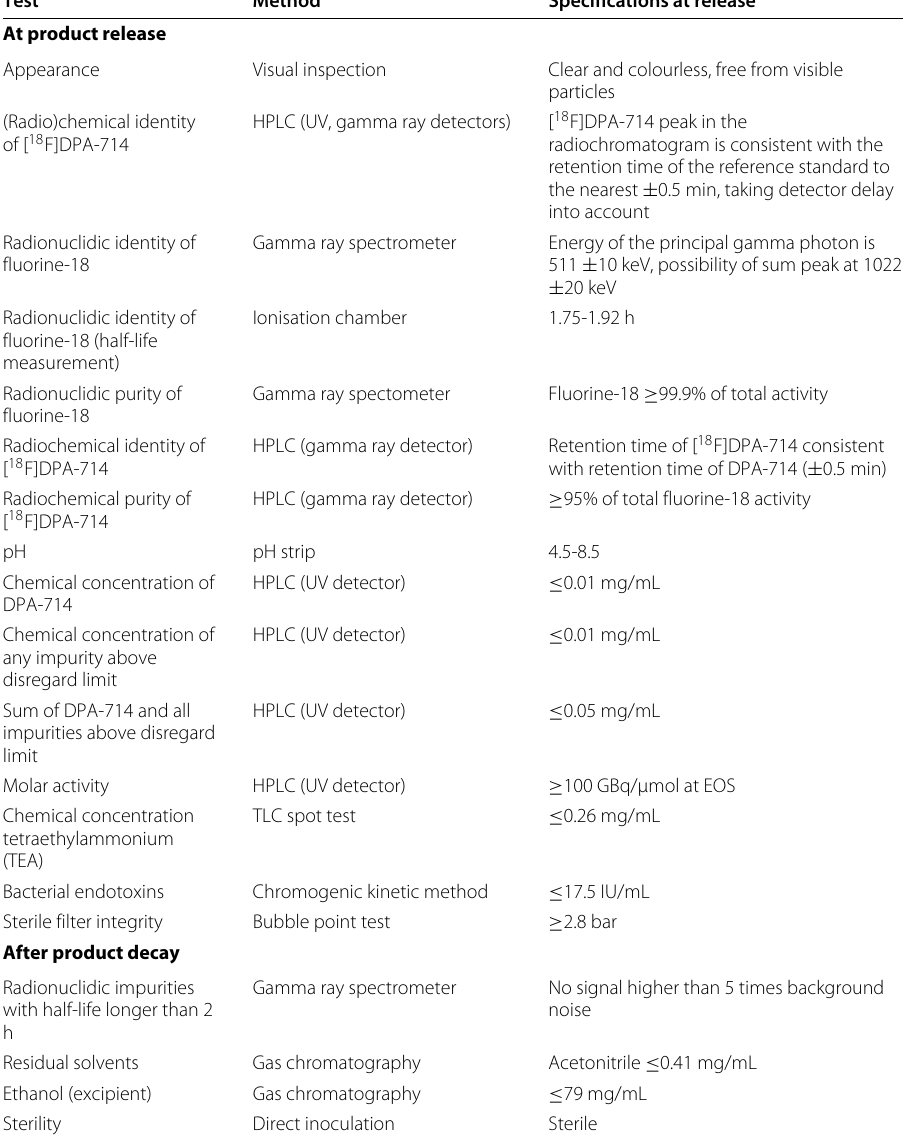
Table 3 Tests, methods and acceptance criteria for the quality control of [ 18